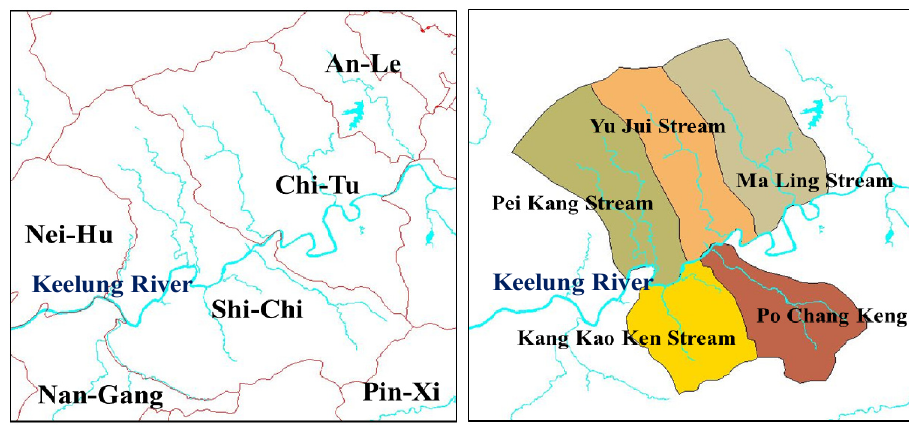
Figure 1. The distribution of river branches in the middle reach of the Keelung River and the corresponding administrative districts and simulation